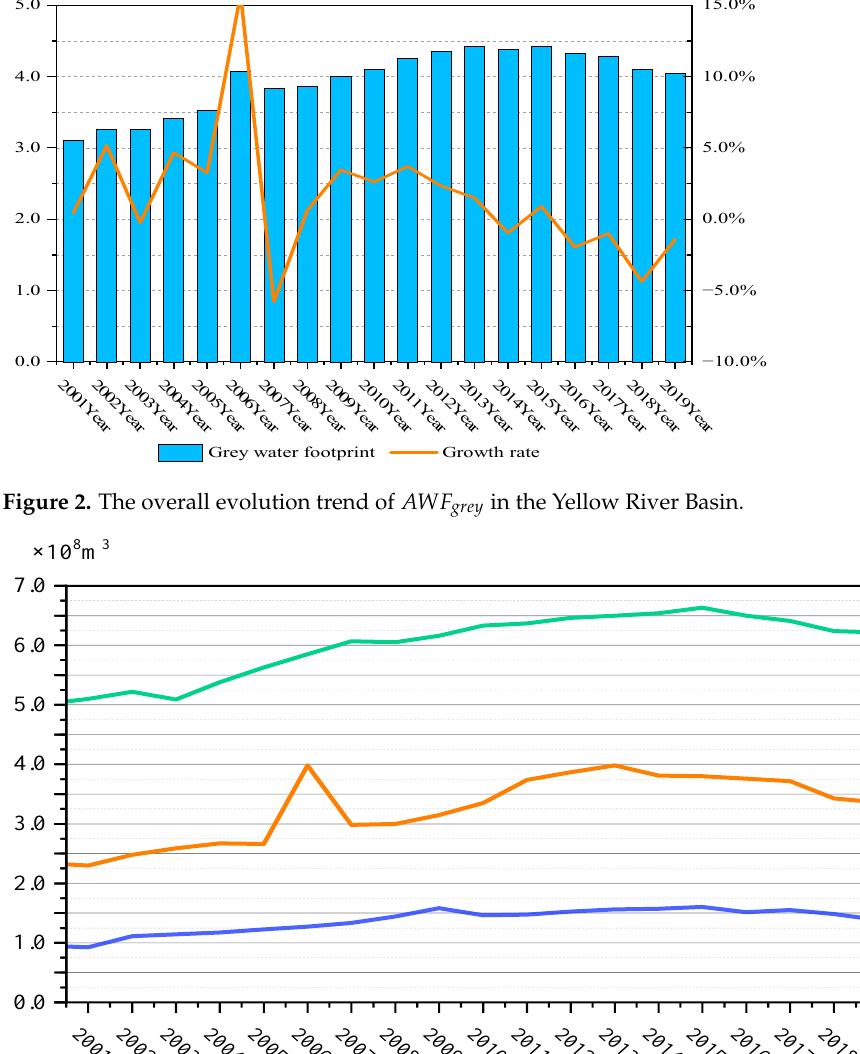
Table 2. Threshold ranges of 𝐴𝑊𝐹 𝑔𝑟𝑒𝑦 in low, medium, high and very high groups (10 6 m 3 ). Groups